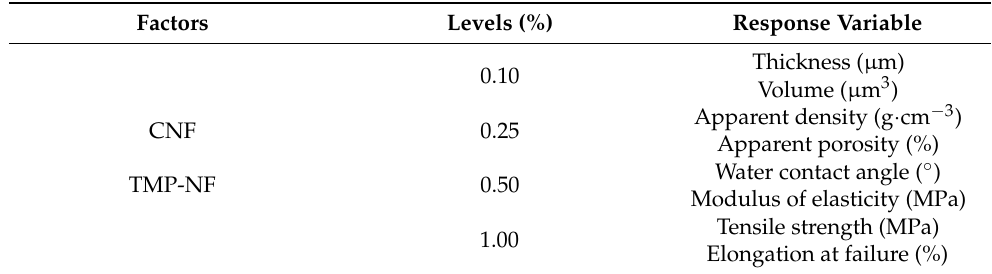
Table 1. General Factorial Experimental Design for film development by vacuum filtration. Factors Levels